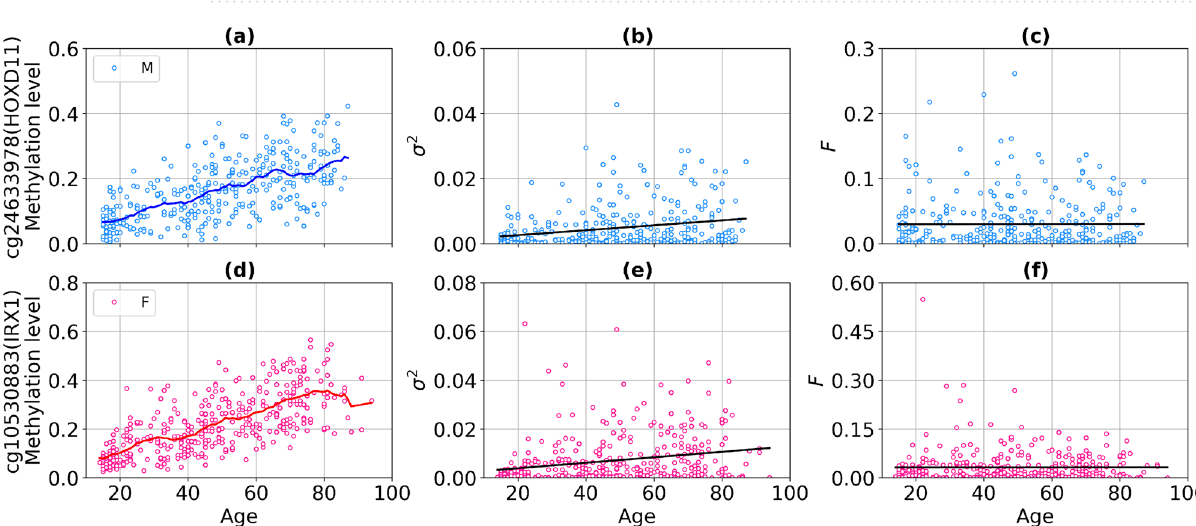
Figure 8. Example of CpG probes for which the squared coefficient of variation (the variability normalized to the squared average beta value) is age independent with a p value > 0.9 in GSE87571 dataset. The top panel presents scatter plots for males: the methylation level ( a ), the variability ( b ), the squared coefficient of variation ( c ). ( d – f ) on the bottom panel present similar graphs for females. Curves represent the average level of methylation taken over a sliding window of 10 years for males (blue curves) and females (red curves). Black lines represent linear regression fits.